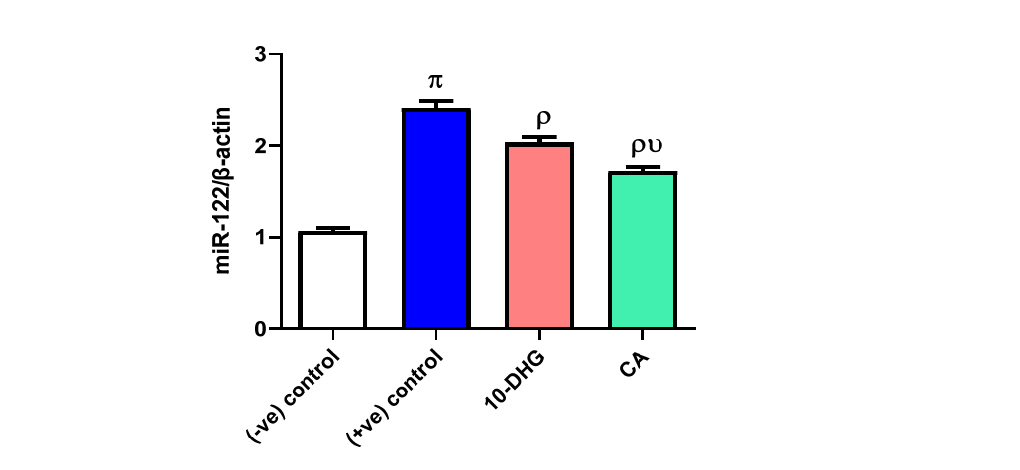
Figure 1. Effects of caffeic acid and 10-dehydrogengerdione treatment on miR-122 expression. (-ve)